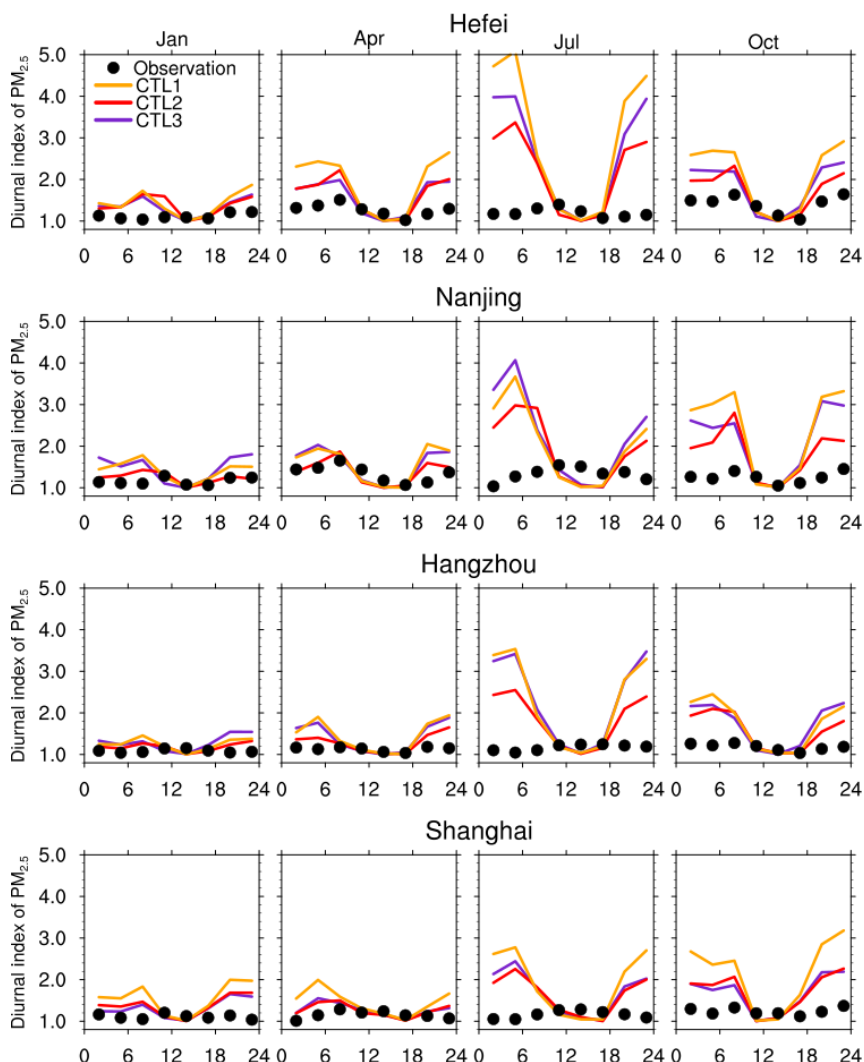
Figure 3. Diurnal index of surface PM 2 . 5 concentrations within 24h averaged over four cities (Hefei, Nanjing, Hangzhou, Shanghai) for January, April, July, and October of 2018 from experiments CTL1, CTL2, and CTL3, and